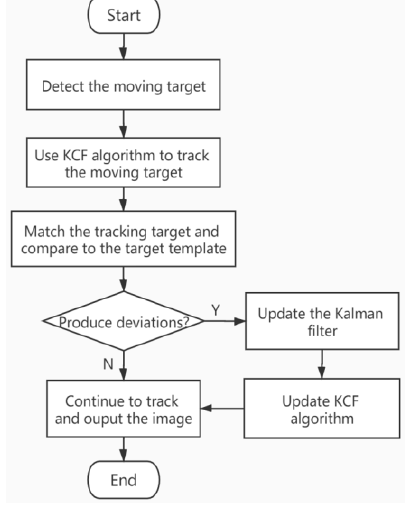
Fig. 1. Flowchart of moving target tracking